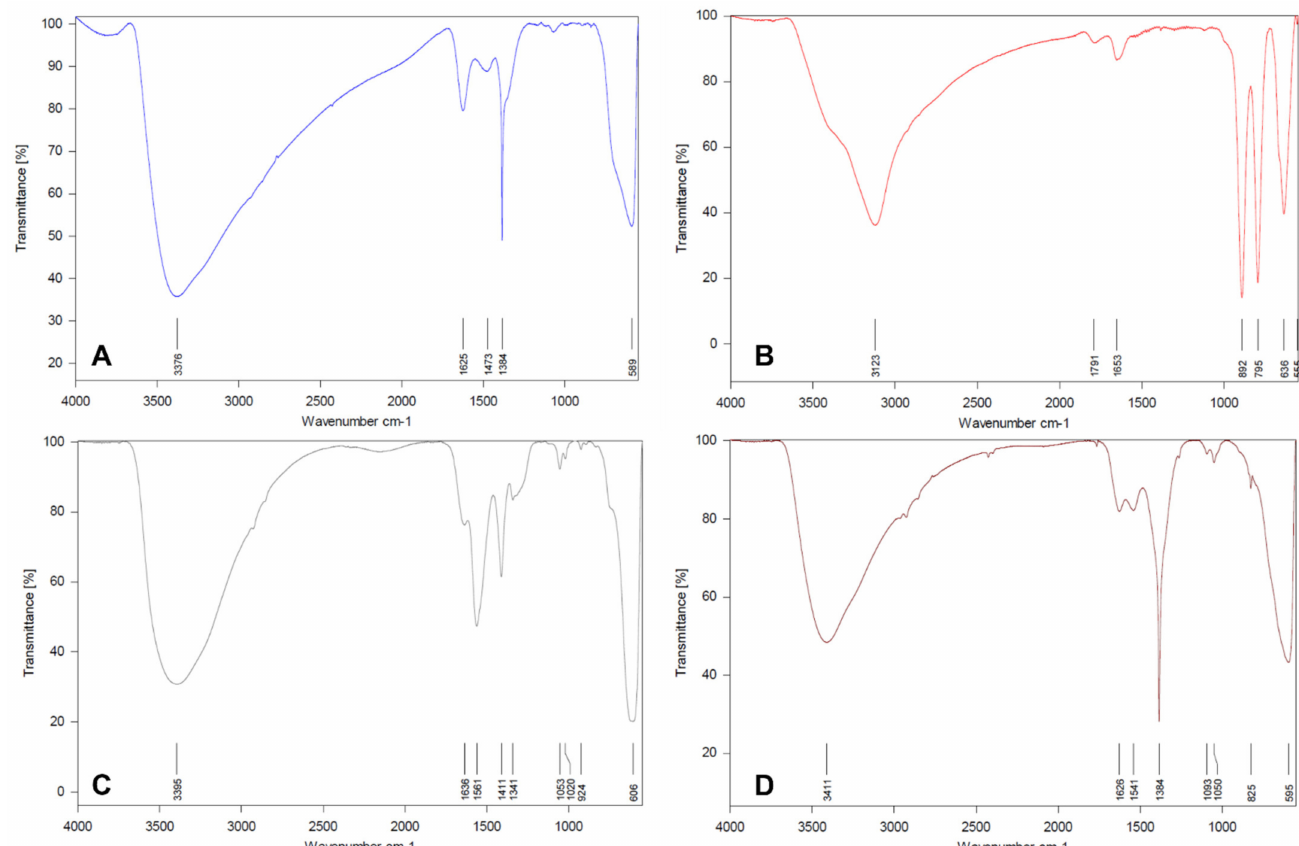
Figure 1. Infrared spectra of 2L-Fh ( A ), goethite ( B ), AMO ( C ) and FMBO ( D ).